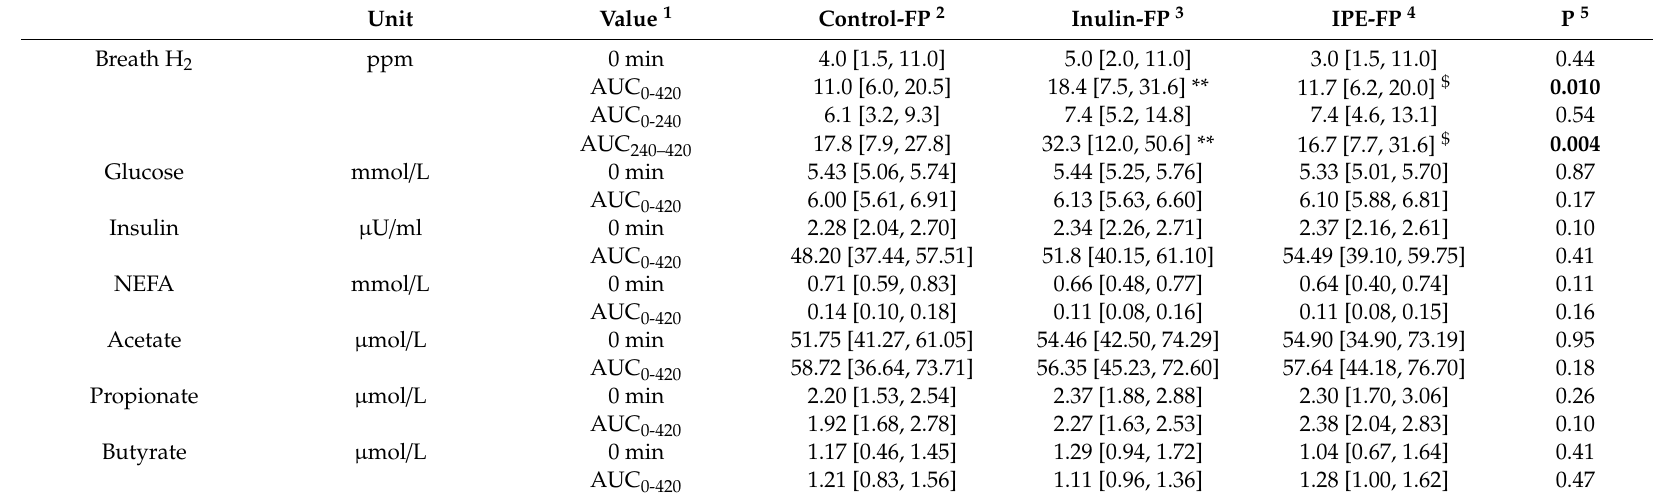
Table 5. Fasting values and AUC for breath H 2 , blood hormones and metabolites following a seven-day supplementation with inulin-FP or IPE-FP compared to